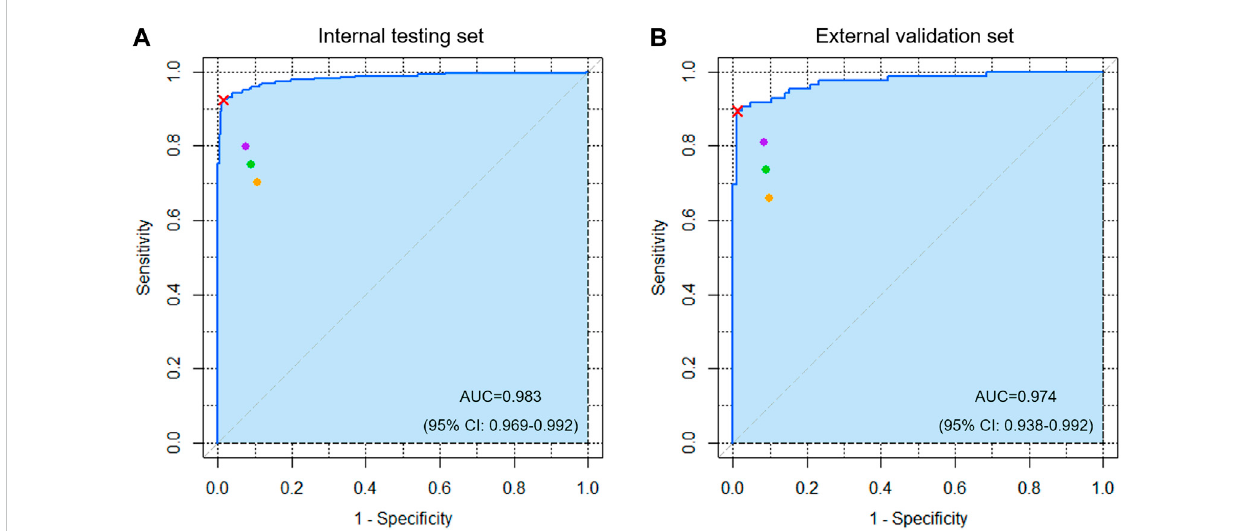
FIGURE 2 The receiver operating characteristic (ROC) curve of the detection algorithm for acetabular fractures in the (A) internal testing and (B) external validation sets. The cyan area indicates AUC. The red cross mark represents the performance on the probability cutoff value calculated by Youden ’ s J statistic. The purple, orange, and green spots represent the performance of fi ve attending orthopedic surgeons, fi ve residents, and ten clinicians, respectively.